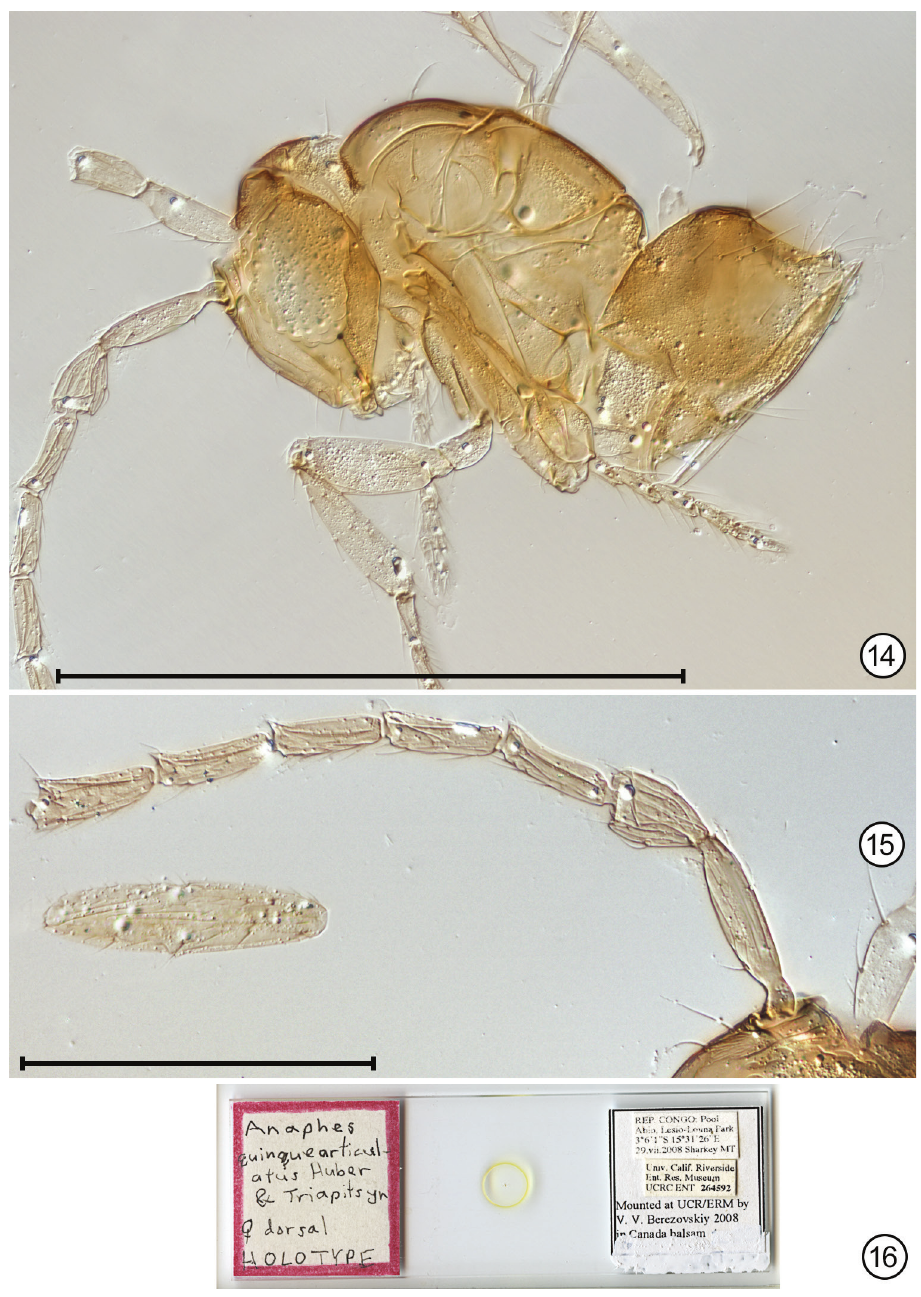
Figures 14–16. Anaphes quinquearticulatus. 14 paratype, lateral habitus 15 antenna 16 holotype slide. Scale bars: 500 μm ( 14 ), 100 μm ( 15